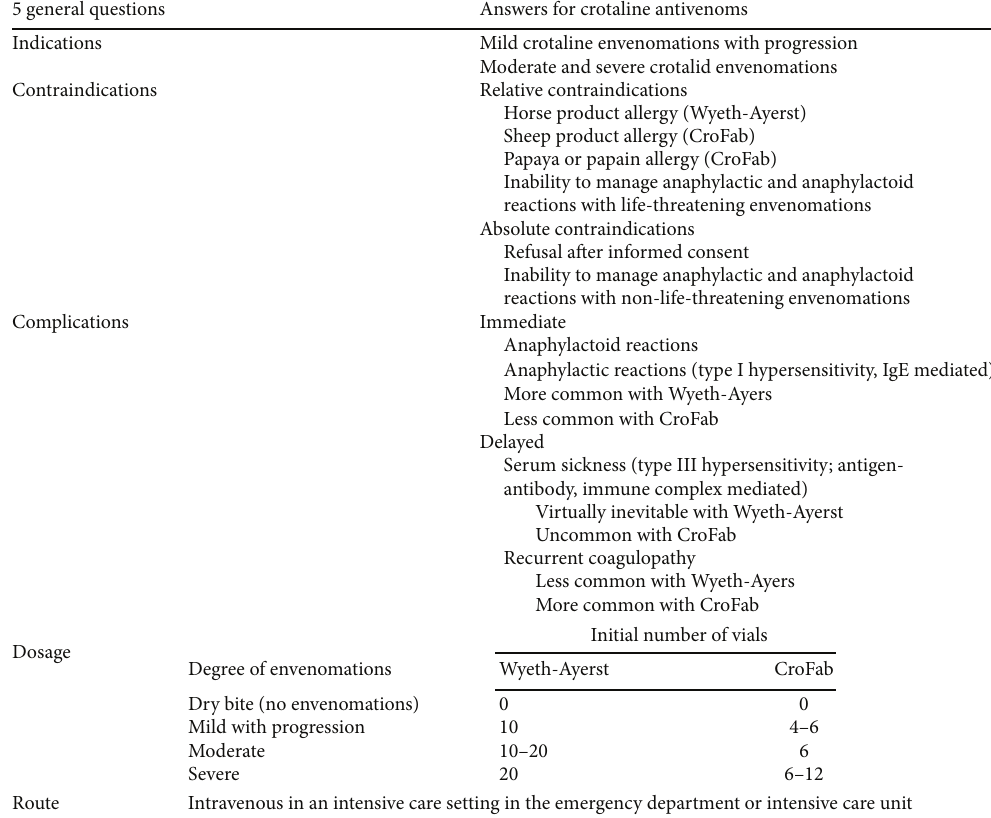
Figure 2: Flowchart of treatment of snake bite by Haddad and Winchester’s (Haddad) Clinical Management of Poisoning and Drug Overdose textbook